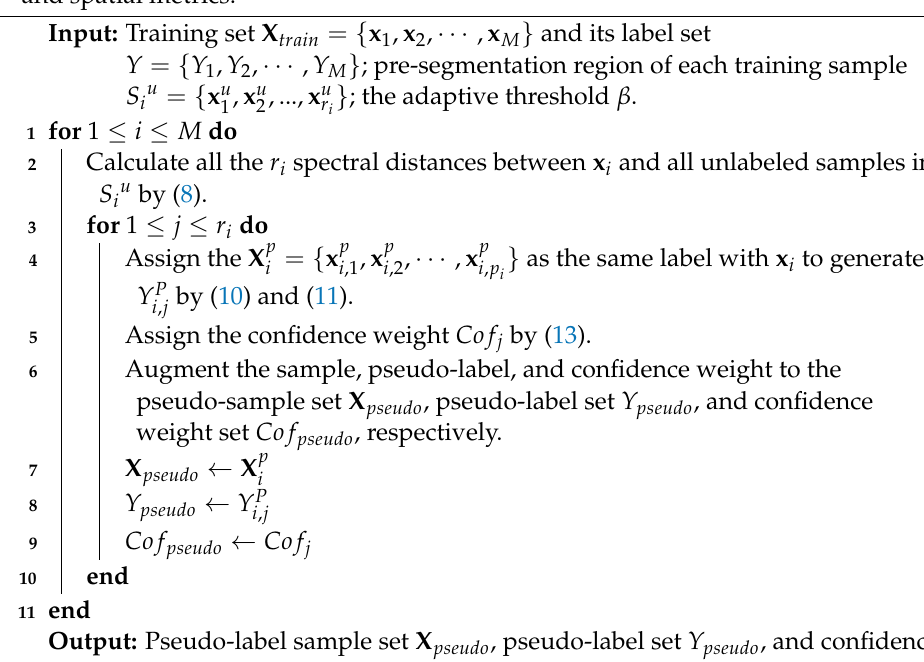
Output: Pseudo-label sample set X pseudo , pseudo-label set Y pseudo , and